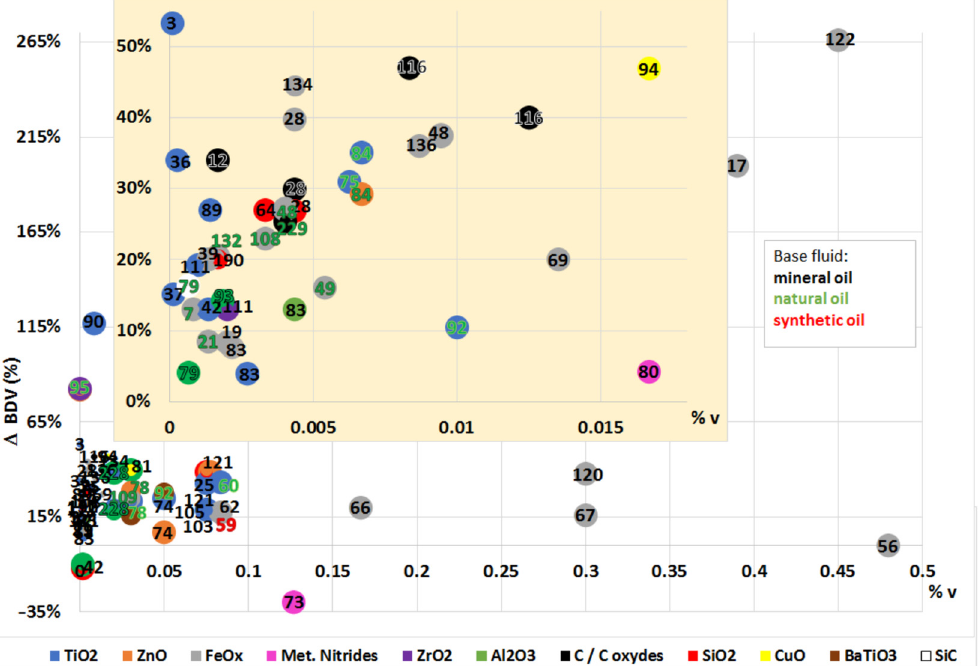
Figure 9. Comparative of the BDV (AC or lightning impulse) maximal variations depending on the base fluid and the volumetric concentration and type of nanoparticles.